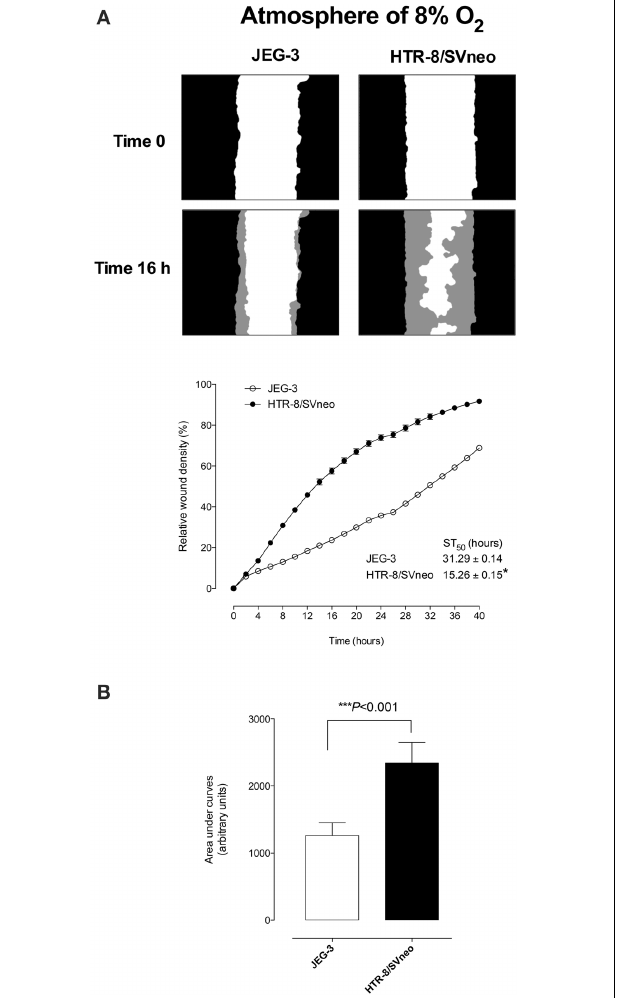
FIGURE 1 | Extravillous Trophoblast invasion. JEG-3 and HTR-8/SVneo cells were grown to confluence in complete media. A wound was made using 96 well WoundMaker and cells were imaged with IncuCyte™ (Essen BioSciences, USA) every 4h for 40h (see Materials and Methods). (A) Top: Representative images of JEG-3 and HTR-8/SVneo cell migration at 16h. The gray region denotes the area of the initial wound covered by advancing cells. Bottom: The time course of JEG-3 and HTR-8/SVneo migration. Insert: half-maximal stimulatory time (ST 50 ). (B) Area under curves analysis from (A) . Data represented as mean ± s.e.m. ( n = 12). In (B) ∗∗∗ p < 0 . 0001 vs.